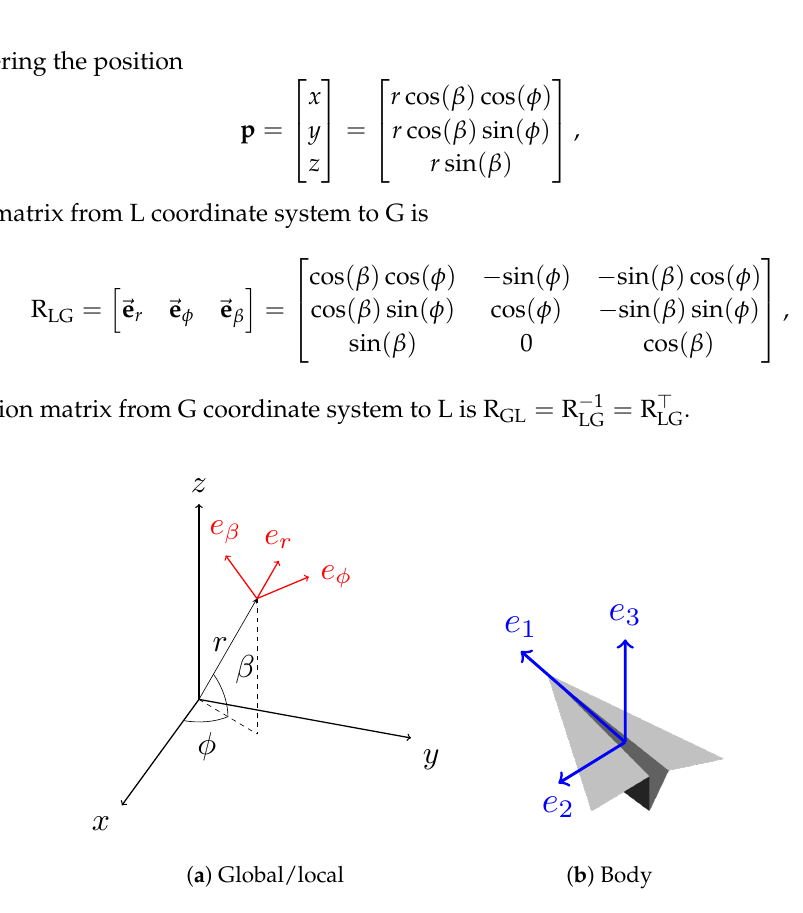
Figure 3. Coordinate